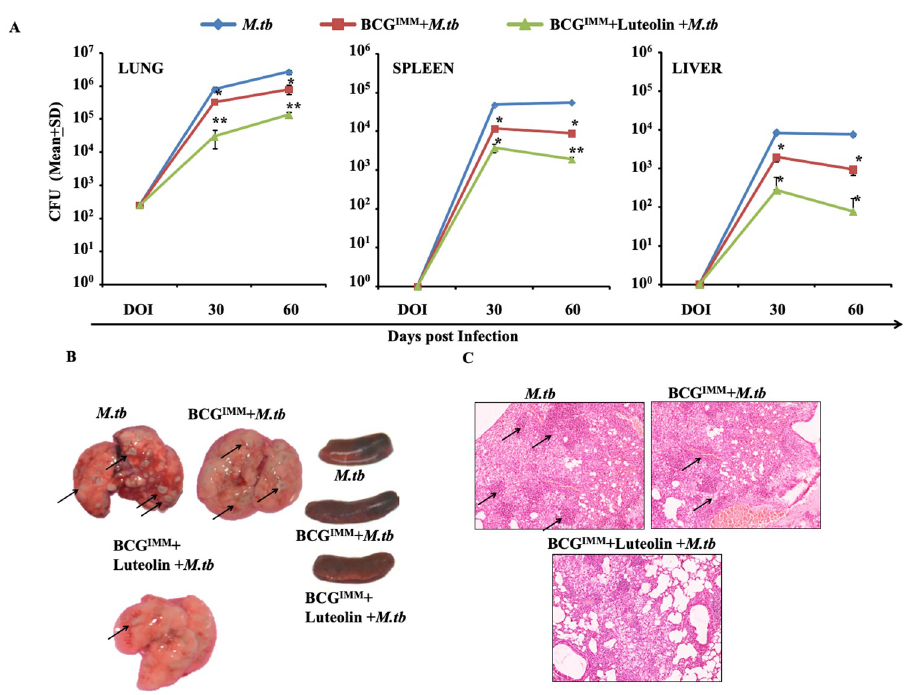
Fig 6. Luteolin treatment of BCG-immunized mice confers improved protection against TB. Mice immunized with BCG were treated with 5 mg/kg of luteolin or vehicle for 20 days and rested for an additional 30 days. These immunized mice and a control group of non-immunized mice were then infected with M . tb . Three randomly selected mice from various groups were euthanized at the indicated time points and lung, liver and spleen were harvested and homogenised. (A) CFUs from the lung, spleen and liver homogenates of M . tb infected mice. (B) Gross pathology of lungs and spleen at different time points after M . tb infection. Arrows indicate granulomatous lesions. (C) Lungs were dissected out and preserved in 10% neutral buffered Formalin (10% NBF). These preserved lungs were then processed for paraffin embedding, sectioning and staining with Hematoxylin and Eosin (H&E). Arrows indicate granulomatous lesions. Data represented as the mean ± STDEV values from data pooled from three experiments with five mice per experiment. Differences were considered significant at P < 0.05 using one way ANOVA. � p < 0.05, �� p < 0.005, ��� p <